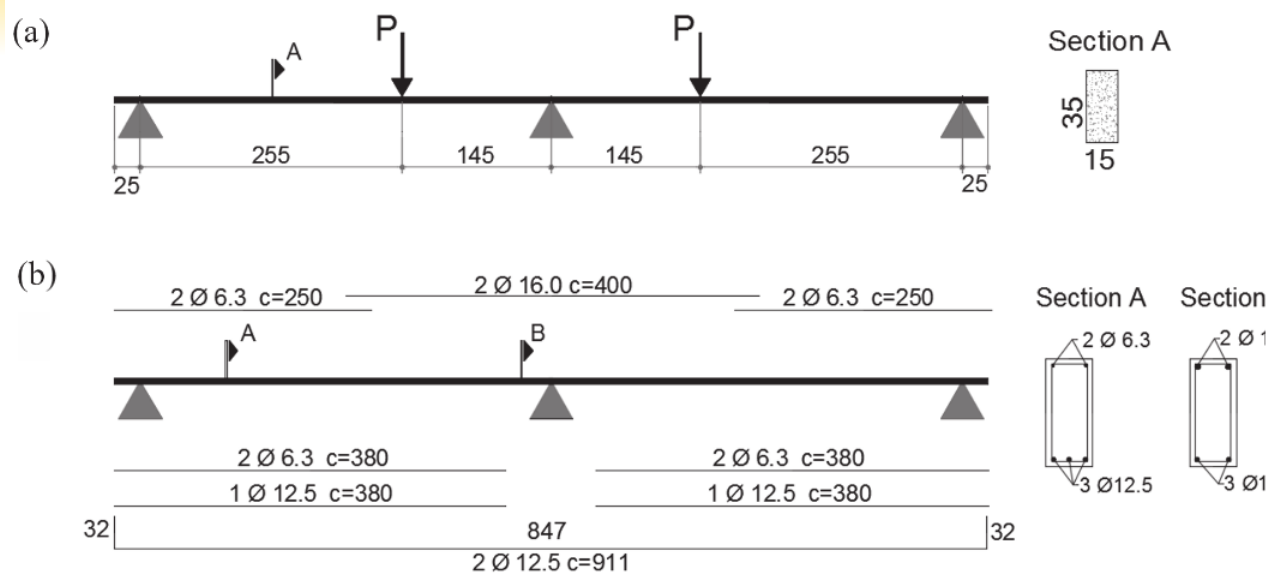
Beam tested by Cruz [14]: a) geometry and loading pattern; b) longitudinal reinforcement detailing (dimensions in cm)